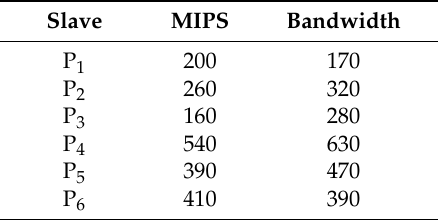
Table 1. Slave setup for the simulation.